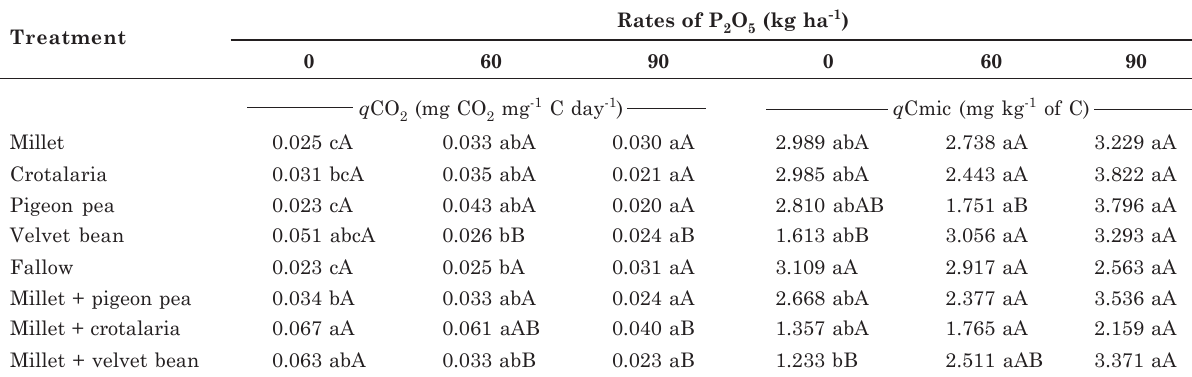
Table 5. Comparison of means for the metabolic quotient ( q CO 2 ) and microbial quotient ( q Cmic) according to the cover crops and rates of P 2 O 5 applied at bean sowing Treatment